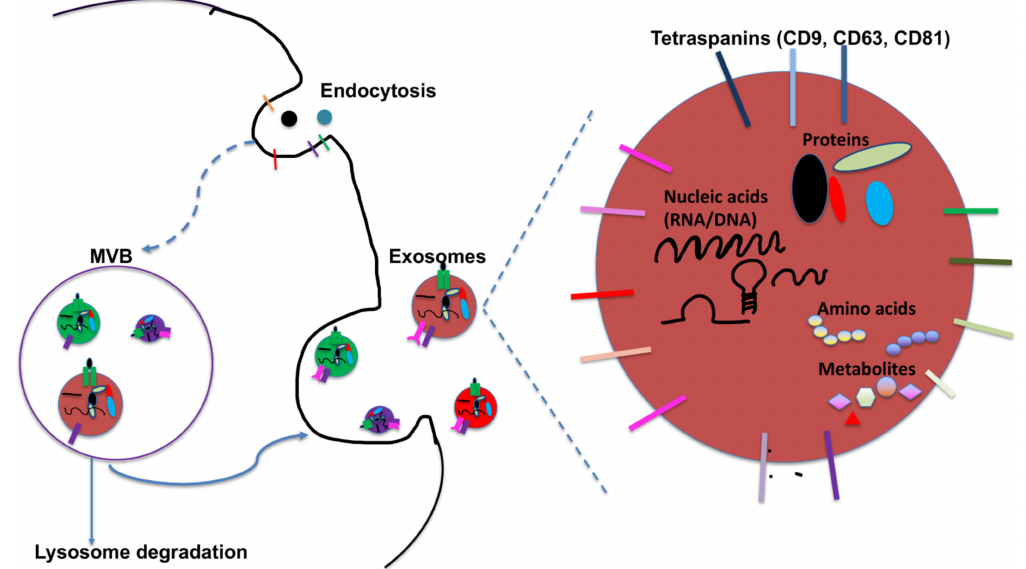
Figure 1. Biogenesis and characteristics of exosomes. Exosomes are produced in the endosomal compartment by inward budding of limiting endosomal membrane into intraluminal vesicles (ILVs) within the lumen of multivesicular bodies (MVBs). MVBs are either targeted for lysosomal degradation or they may fuse with plasma membrane to release these ILVs into the extracellular space as free exosomes. Exosomes are highly heterogenous with size ranging from 40 to 160 nm. Besides expressing an array of receptors on their surface, exosomes carry proteins, metabolites and nucleic acids including mRNA, miRNA, other non-coding RNA and DNA. Tetraspanins (CD9, CD63 and CD81) and other proteins such as Alix and TSG101 are often enriched in exosomes, and are commonly used as markers for